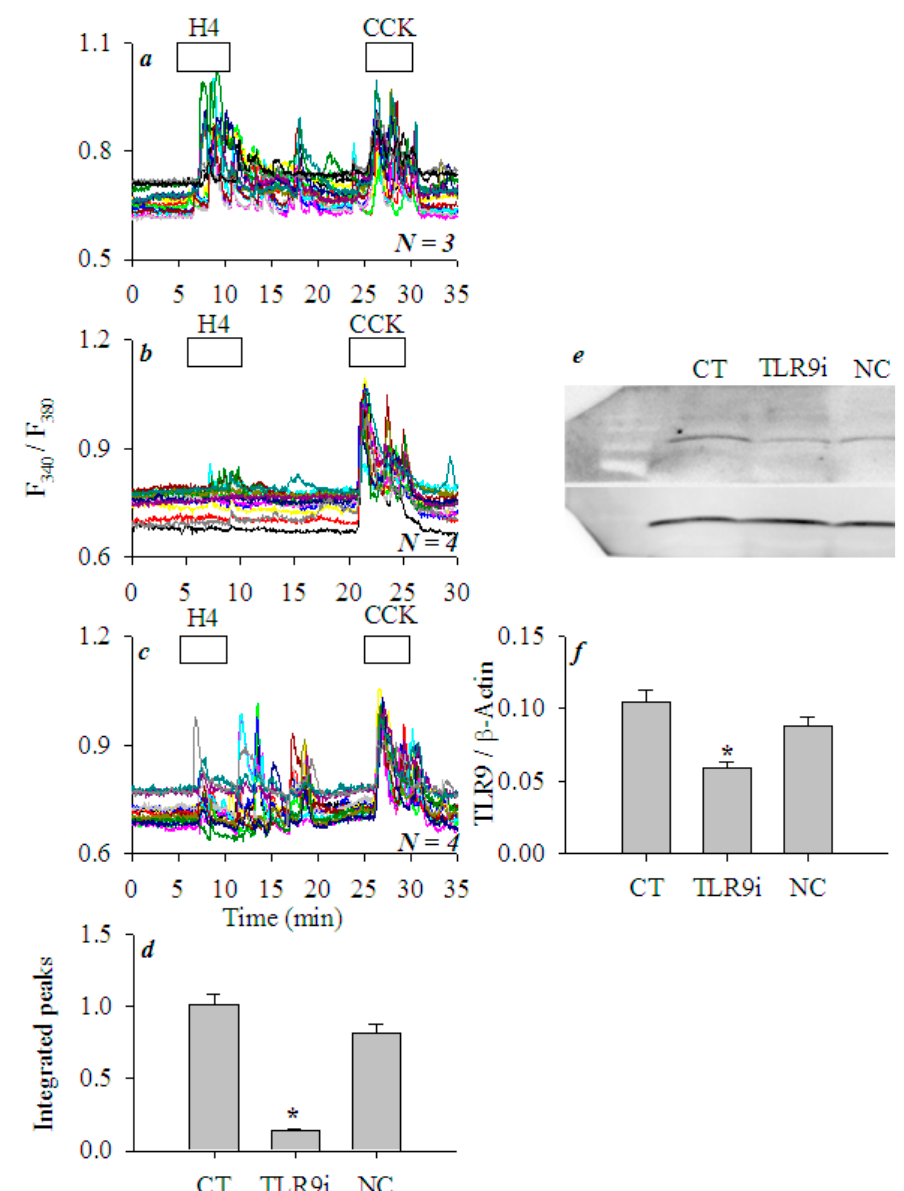
Figure 7. siRNA down-regulation of TLR9 expression blocked histone-triggered calcium oscillations in AR4-2J cells. AR4-2J cells were cultured as normal control ( a ), transfected with siRNA-TLR9 ( b ) or with scrambled siRNA ( c ), loaded with Fura-2 AM, and perifused. H4 (5 mgL − 1 ) and CCK (20 pM) were added as indicated by the horizontal bars. The H4-induced calcium oscillations ( a – c , peak area above baseline from 5–20 min) were calculated ( d ). Western blot images ( e ) and statistical analysis ( f , N = 3) of TLR9 protein content are presented. Abbreviations: CT, not transfected; TLR9i, transfected with siRNA-TLR9; NC , transfected with scrambled sequence. AR4-2J cells were analyzed for both calcium and TLR9 protein content 24 h after transfection. Protein content of -actin was used as an internal reference for TLR9 (TLR9/-actin). Asterisk (*) indicates statistical significance at P < 0.05. Other than direct triggering of calcium oscillations, extracellular histones were also found to sensitize CCK1 receptor activation in AR4-2J cells. Extracellular histone sensitization of CCK1 receptor activation was observed when CCK1 receptors were activated either reversibly by CCK or irreversibly by photodynamic action (see Figure